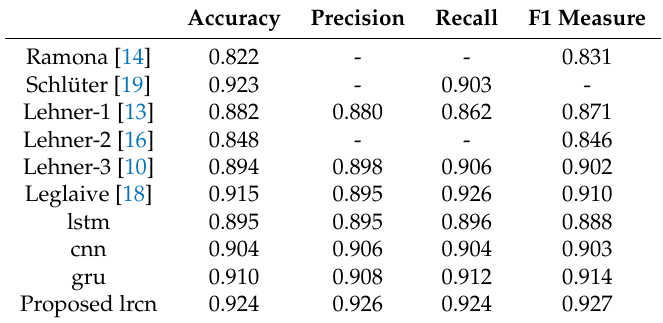
Table 3. Proposed singing voice detection system compared with existing methods on the Jamendo